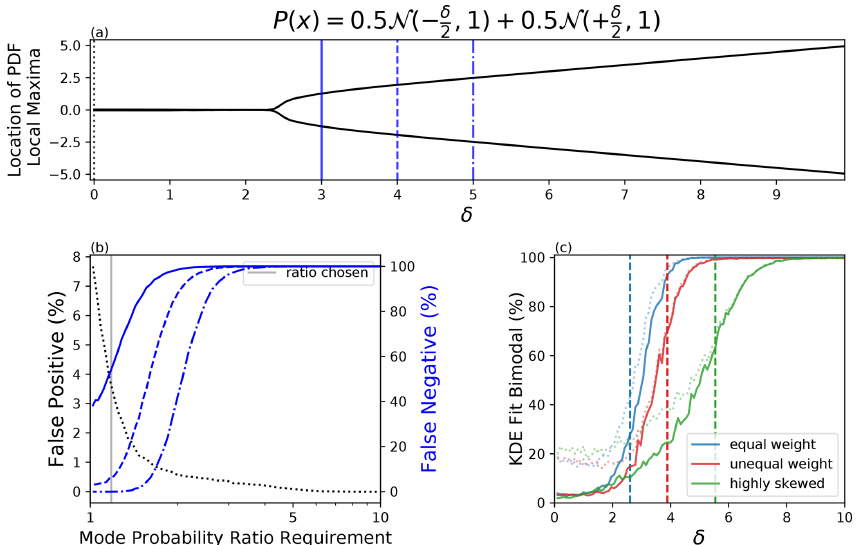
Figure 3. (a) The local maximum location(s) for a series of bimodal distributions with increasing δ according to the PDF of that distribution. (b) The false-positive (black dotted) and false-negative (blue) rate that is associated with various minimum mode probability ratio require- ments in order to classify the bimodality of a subsampled 50-member sample fit with a KDE for three different underlying distributions (solid, dotted, dot-dashed) (the mode probability requirement is in combination with a 5-member minimum mode requirement). The mode probability requirement used in panel (c) is demarcated by a vertical gray line. (c) The bimodal fit percentage for a 50-member sample fit with a KDE. Vertical dashed line represents when the underlying distribution truly transitions from unimodal to bimodal. The correspondingly colored dotted line represents the percentage of time the KDE classified bimodal with only a two-mode requirement. The correspondingly colored solid line represents the same statistic except while using the following restrictions: two modes, either mode probability ratio must be greater than 1.18, and a five-member minimum for each mode. The blue distribution represents the distribution in panel (a) . The red distribution represents the same distribution as panel (a) but with a weight of the lower mode 3 times that of the higher mode; for many values of δ this would be representative of a skewed distribution. The green distribution represents the same as panel (b) , but the greater weighted mode has a standard deviation of 2 instead of 1; for many values of δ this results in a highly skewed distribution.